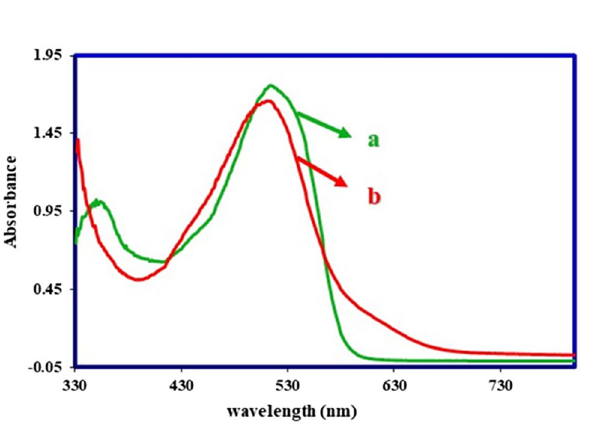
Figure 21. Results of the dyeing process of produced nitromefenamic acid ( 2 ) for different fabrics: ( a ) before dyeing and ( b ) after dyeing.